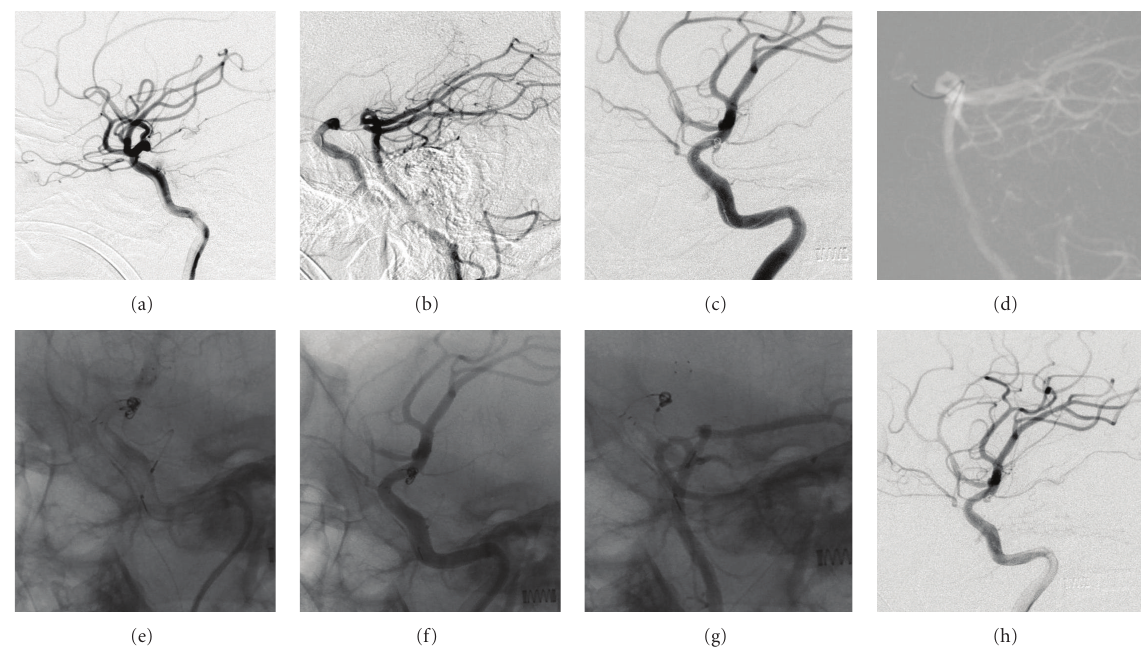
Figure 2: Endovascular coil embolization of ruptured ID of the PCo-A. (a) DSA before treatment showed that a funnel-shaped expansion with a diameter of 2 mm occurred at the origin of the right posterior communicating artery and was in conjunction with the posterior communicating artery at its apex. (b) Vertebral angiography showed that blood flew reversely from the posterior communicating artery into the internal carotid artery system after carotid artery compression. (c) A Neuroform3 stent was released in the internal carotid artery to cover the origin of the posterior communicating artery; an Echelon-10 microcatheter was used to release a Hydrocoil10 coil into the PCo-A ID through the stent mesh using a Transend300 microguidewire, but the coil was not detached. (d) A microcatheter was placed into ID of the PCo-A through the posterior vertebral artery and posterior communicating artery under the guidance of Roadmap. (e) Four Hydrocoil10 coils were released into ID of the PCo-A through anterior and posterior circulation. (f, g) No enhancement of ID of the PCo-A was noted after five coils had been filled into anterior and posterior circulation, and there was no contrast agent leakage. (h) Angiography of coils in anterior and posterior circulation after they were all detached, showing no enhancement of ID of the PCo-A and the posterior communicating